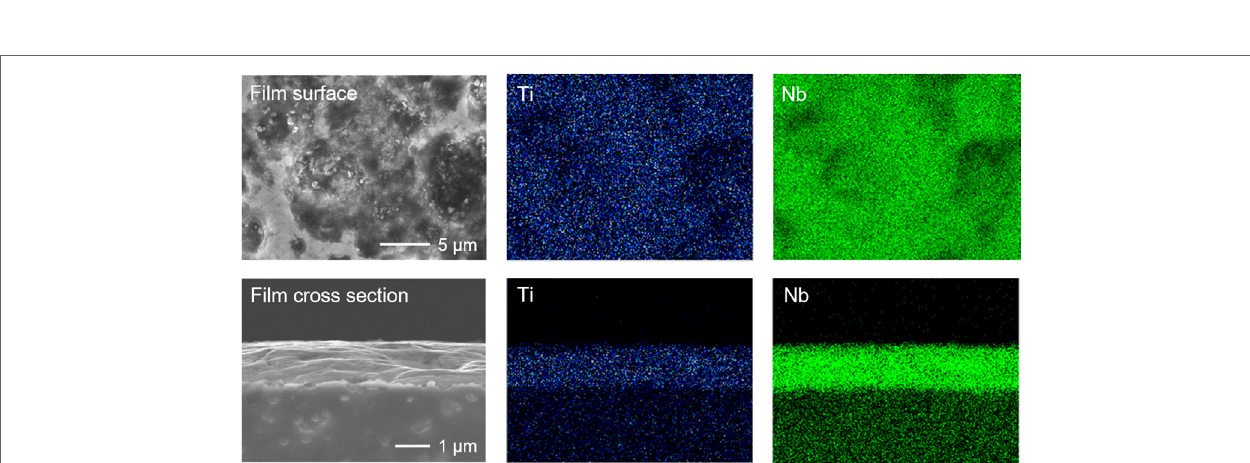
FigUre 10 | seM images for (a) TnO powder used as raw materials for film electrode fabrication by aD, (B) the surface of TnO film electrode, and (c) polished cross section of TnO film electrode . Plastically deformed and/or fractured TNO particles form the dense film on LLBZT via impact consolidation as shown in (D)